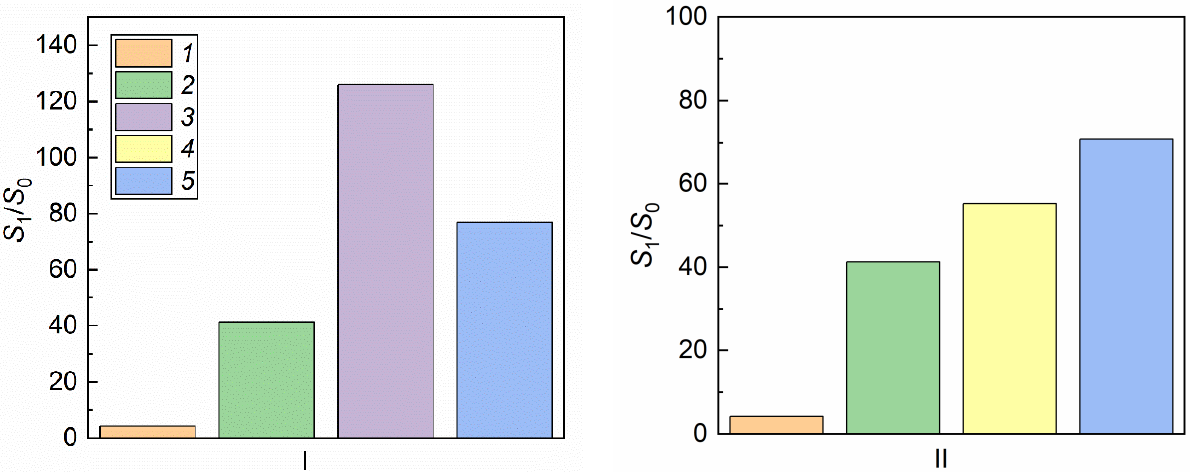
Figure 11. Maximum surface area ratio of an emulsion containing 90 vol% of diesel and 10 vol% of water for combining most effective schemes (I–II), described in [105]: 1—droplet-droplet collisions; 2—exposure to air flow; 3—collision with a heated solid surface; 4—collision with a cold wall; 5—micro-explosive breakup.